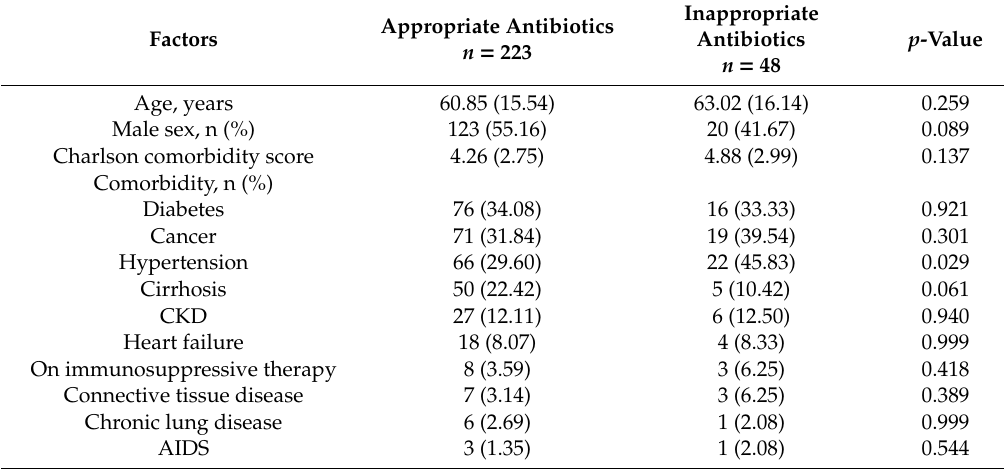
Table 2. Baseline characteristics of patients presenting with bacteremia at the emergency department, categorized by appropriateness of antibiotic